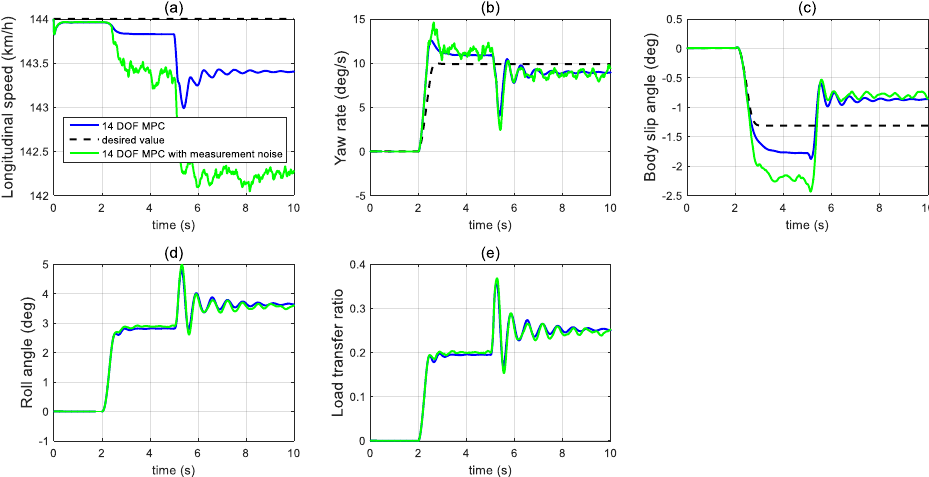
Figure 17. Vehicle dynamics performance when considering the measurement noise in the second set of simulations ( a ) longitudinal velocity, ( b ) yaw rate, ( c ) body side-slip angle, ( d ) LTR, ( e ) roll